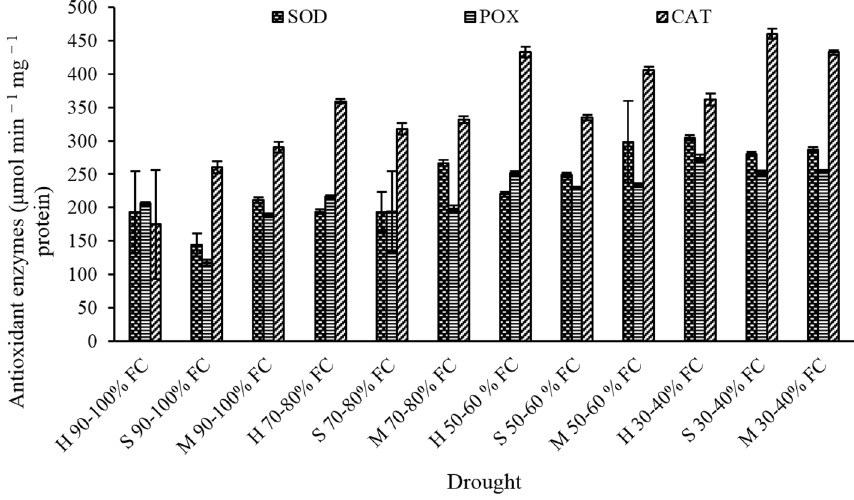
Figure 7. The effect of drought stress on enzymatic activity of SOD, POX and CAT in different lavender